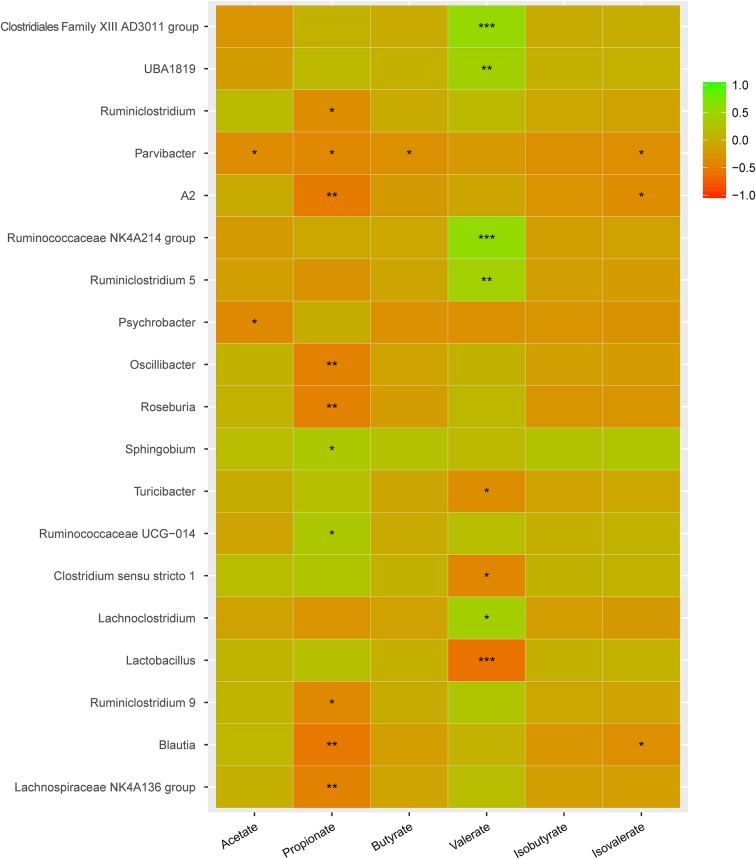
Key genera involved in regulating SCFAs in cecum. Green color represents significant positive correlation and red color represents significant negative correlation, and the independent right color bars depict correlation coefficients between microbiota and SCFAs. Correlation was considered significant when the absolute value of Spearman’s rank correlation coefficient (Spearman’s r) was > 0.6 and statistically significant (P < 0.05). The significance is indicated: *P < 0.05; **P < 0.01; *** P < 0.001.